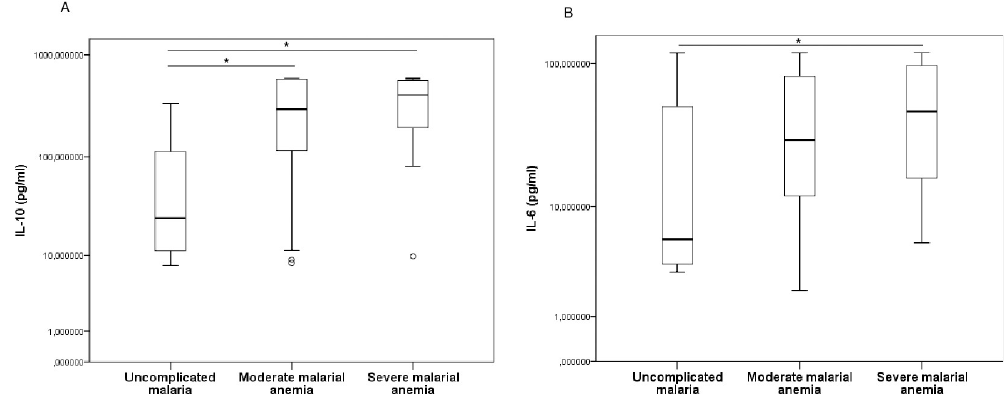
Fig 3. Levels of IL-10 (A) and IL-6 (B) in plasma in children with symptomatic uncomplicated malaria, moderate malarial anemia and severe malarial anemia. Concentrations were quantified using enzyme-linked immunosorbent assays (ELISA) and compared between the different groups in pairs. Cytokine concentrations were represented by boxplots with medians and interquartile range (IQR) in pg/ml on the log10 scale. Statistically significant differences between groups were tested using the Mann–Whitney method and are represented as � p < 0.05; �� p < 0.001; ��� p = 0.0001; ���� p <